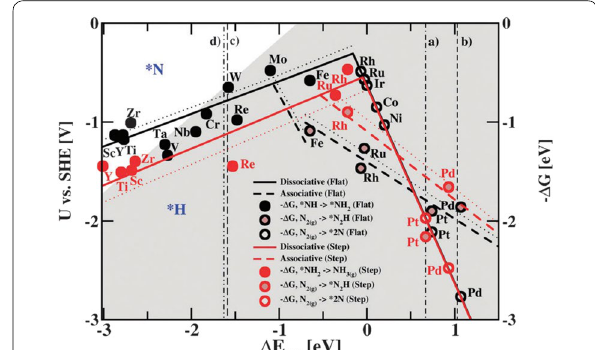
Fig. 3 Volcano plot for the NRR on metal surfaces with specific mechanistic assumptions. A shaded area in the plot represents the overlaid volcano diagram for the HER counterpart (Reproduced with permission [16] Copyright 2012, Royal Society of Chemistry